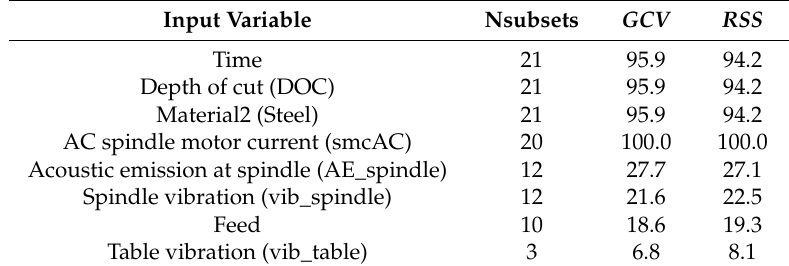
Table 7. Coefficient of determination ( ABC-MARS-based model fitted in this study.